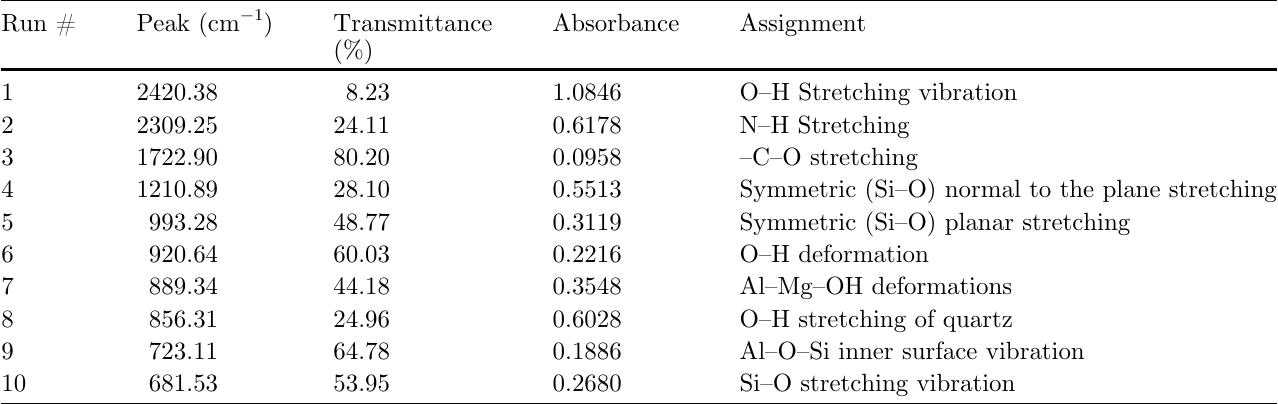
Table 5. FTIR spectrum values for kaolin fi lled polyurethane